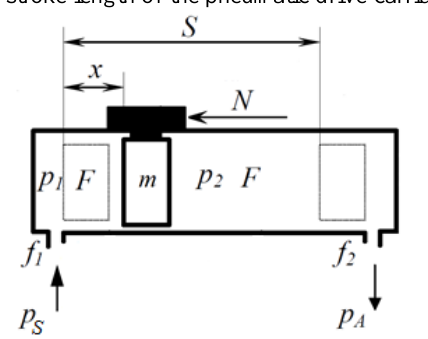
Figure 1. Rodless pneumatic actuator circuit scheme